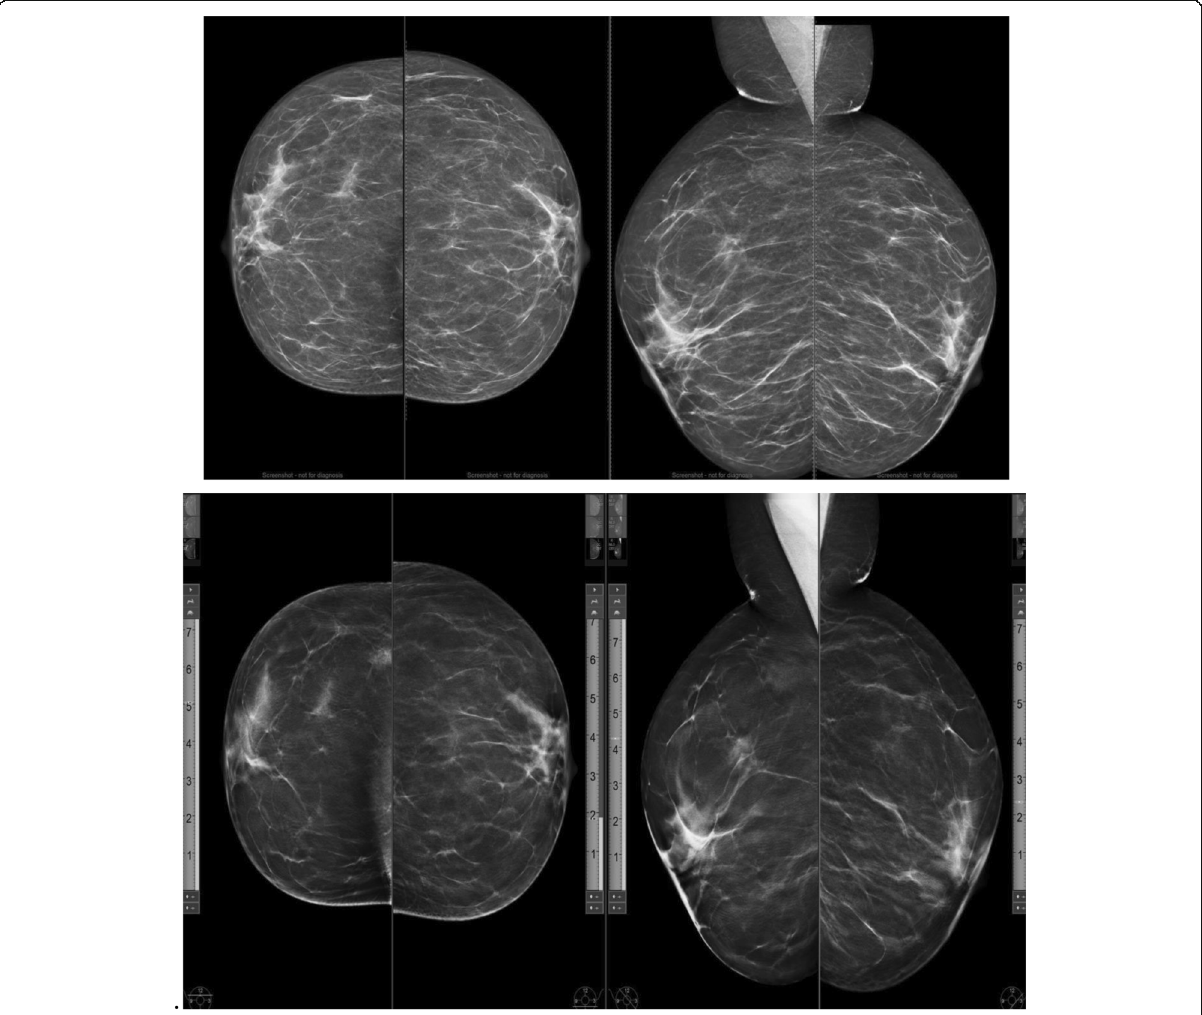
Fig. 5 Fifty-three-year-old female. Mammography CC and MLO view. Scattered fibro-glandular breasts parenchyma (ACR B). Focal asymmetry is noted at the UOQ of the right breast BIRADS 3. No dominant spiculated masses or pathological micro calcifications seen. Tomosynthesis of both breasts CC and MLO views. The upper outer area of focal asymmetry was confirmed to be an area of over lapping fibro-glandular tissue with dirty lucencies appearance, BIRADS 2. Tomosynthesis downgraded the BIRADS from 3 to